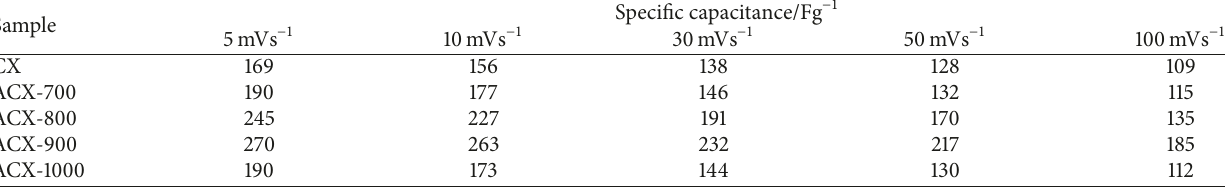
Table 4: Specific capacitance of the CX and ACX electrodes in 6 M KOH electrolyte determined by cyclic voltammetry at various scan rates of 5 to 100mVs −1 .